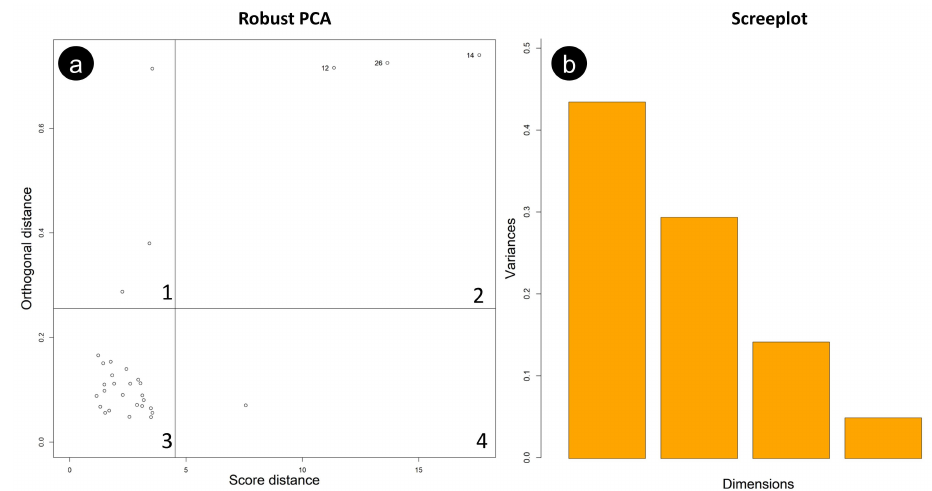
Figure 7. Figure 7. ( a ) RPCA diagnostic plot; ( b ) scree plot. Using an indicative cut-off value of about 0.32 for loadings [29,30], EFs of Cr, Cd, Cu, and Zn have been considered representative of PC1, EFs of Hg and, subordinately, Cr have been selected for PC2 and, finally, EFs of Sn, Be, and V have been associated with PC3 (Table 3). The representative elements chosen for PC1 are all positively correlated among themselves. Conversely, the second component (PC2) shows a strong dependence on the Hg EF’s variability, negatively correlated with the Cr EF (Figure 8). The third component (PC3) shows significant loadings for the EFs of Sn, Be, and V (Table 3).